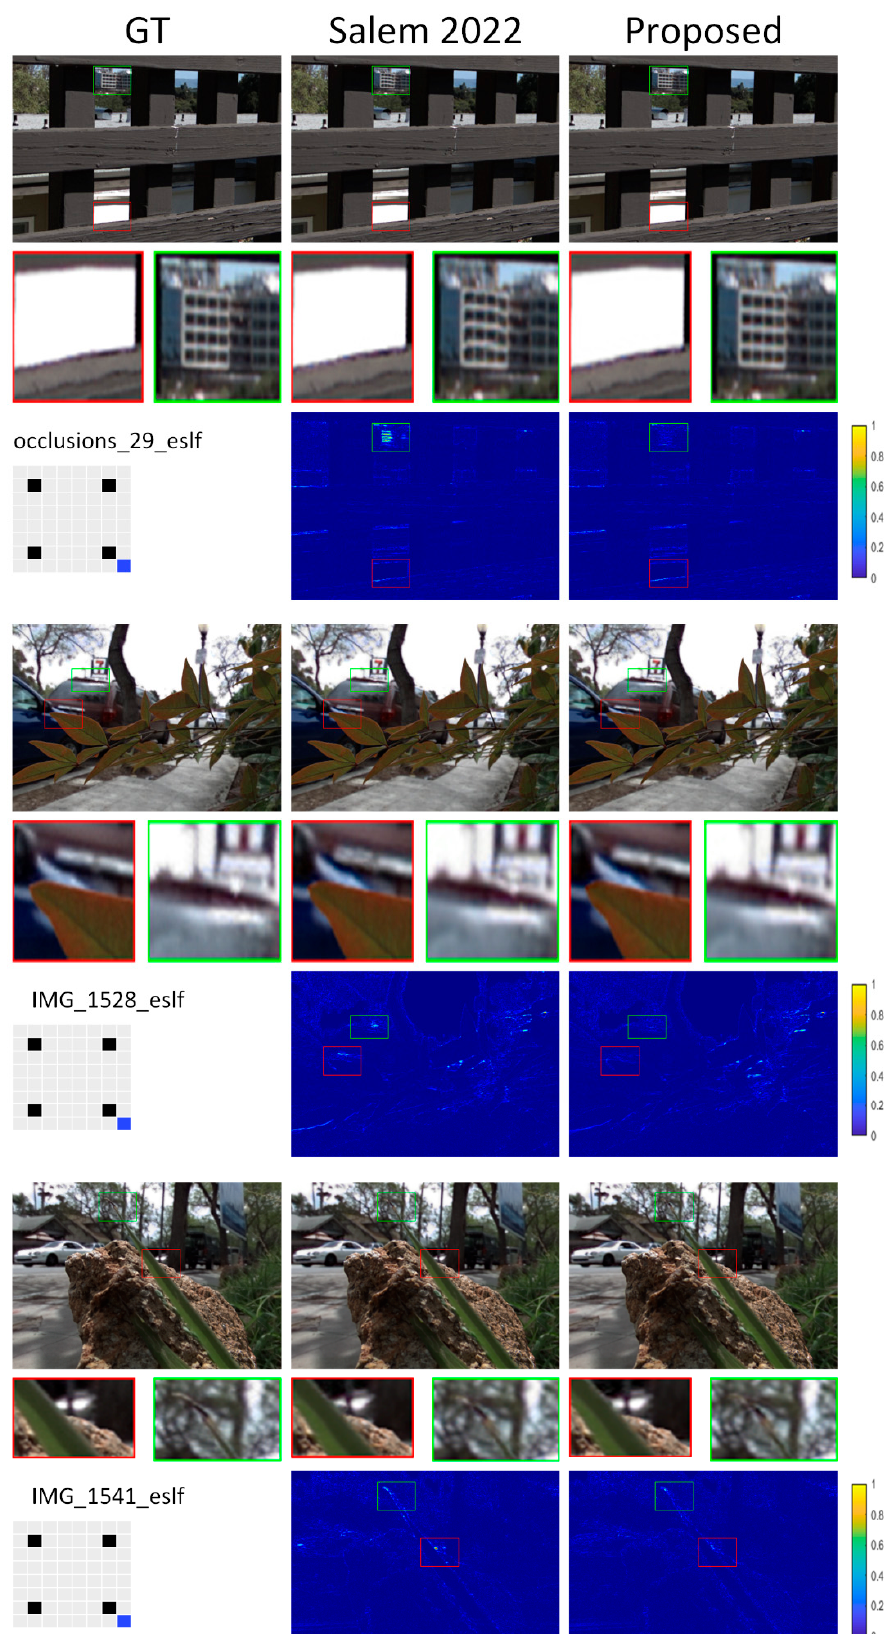
Figure 8. Visual comparison of the proposed model to reconstruct 8 × 8 views out of 2 × 2: extrapo- lation 1 at an extrapolated view.